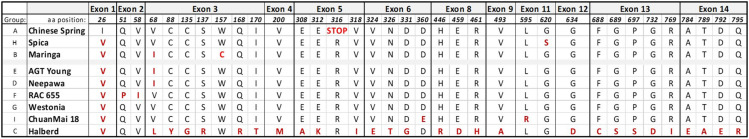
Polymorphic non-synonymous nucleotide changes leading to amino acid changes in the different allele groups. Differences in amino acids and their position in the deduced LMA-1 protein sequence are indicated. Outliers are highlighted in red.